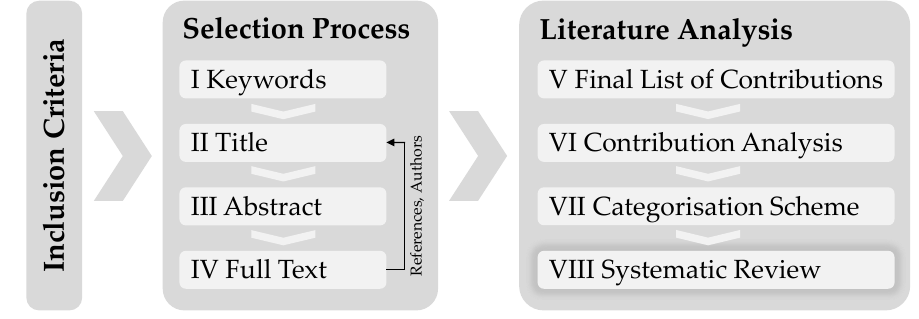
Figure 2. Method of the literature review.